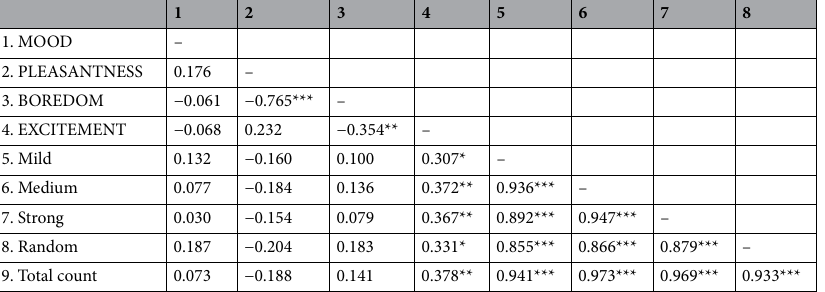
Table 2. Spearman’s rank-based correlations between mood change, ratings of the thinking period, and counts of self-administered shocks during the thinking period. * p < .05, ** p < .01, *** p <